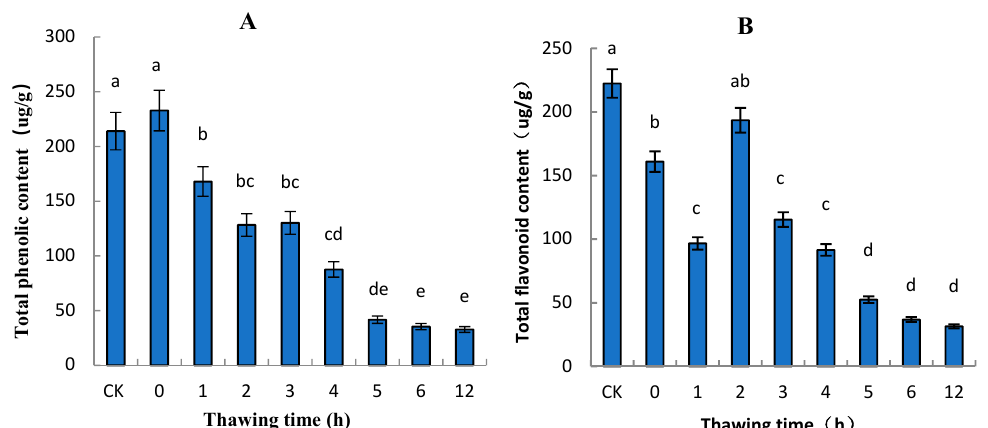
Figure 3. Changes in total phenolic ( A ) and flavonoid content ( B ) in “Ruaner” pear during the freezing–thawing stage. Different letters indicated significant differences between thawing time treated and control (Duncan’s multiple range test, p < 0.05).